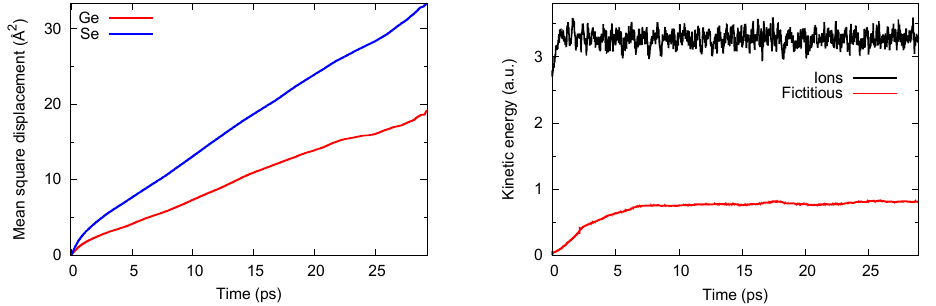
Figure 1. Left side : behavior of the mean square displacement for liquid GeSe 4 at T = 1073 K. Right side : total kinetic energy for the ionic ( top part ) degree of freedom and the fictitious electronic degrees of freedom ( bottom ). Without loss of generality, we are referring here to FPMD calculations performed within the MLWF scheme for the dispersion forces.